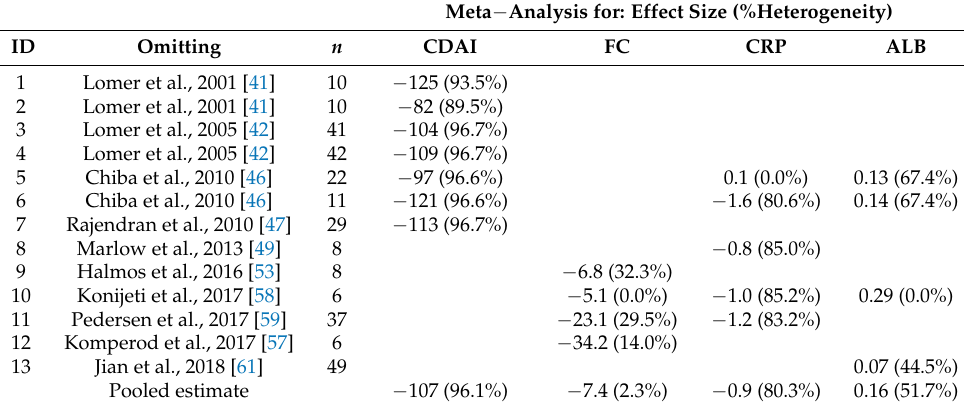
Table 5. Influence analysis in a meta-analysis using the leave-one-out method (random effect). Meta − Analysis for: Effect Size